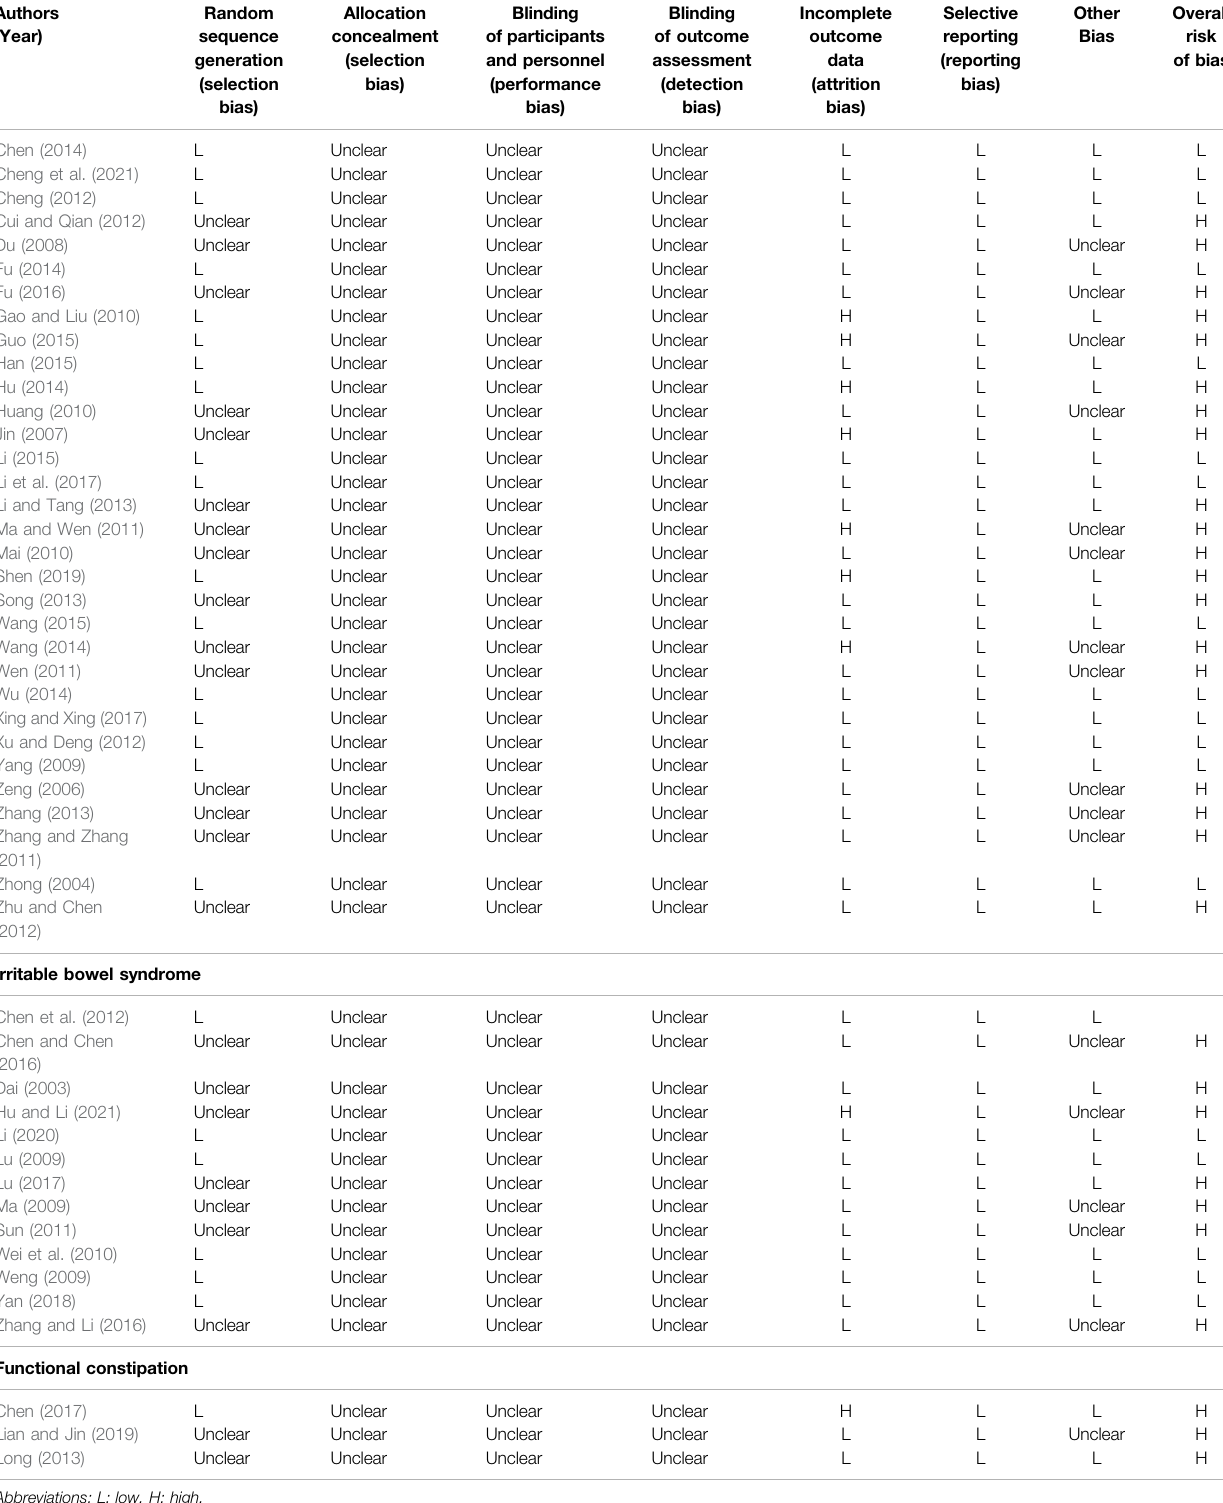
TABLE 3 | Assessment of the risk of bias of each included